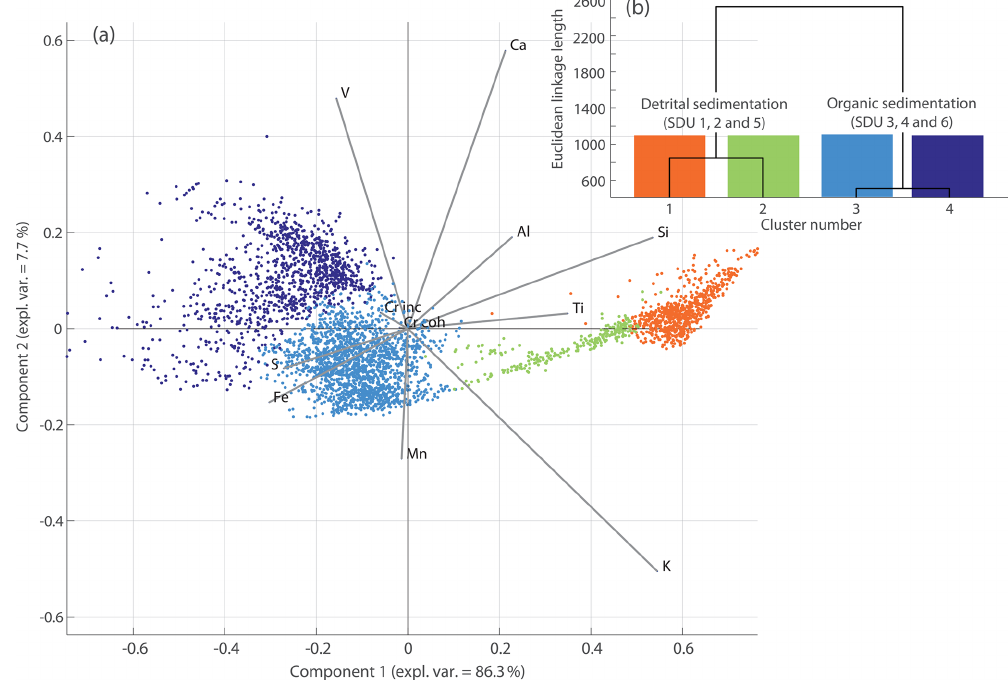
Figure 7. Statistical analyses of the XRF profiles from Lake Kälksjön (KKJ) sediments. (a) Covariance biplot visualizing the correlations of the main elements with regard to the first two principal components. (b) Hierarchical clustering solution reflecting the difference between the detrital sediments of SDUs 1, 2 and 5, as well as organic sediments of SDUs 3, 4 and 6.